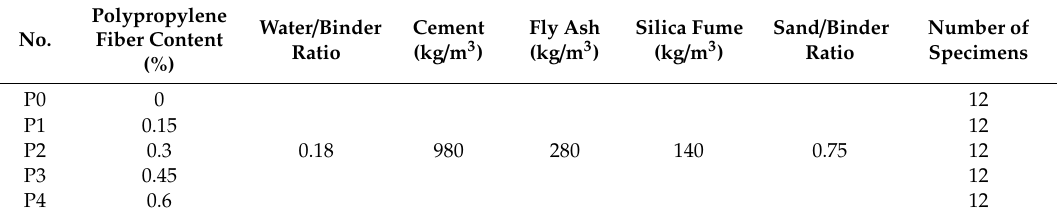
( e ) Figure 8. Splitting tensile strength failure mode of polypropylene fiber RPC: ( a ) 0%, ( b ) 0.15%, ( c ) 0.3%, ( d ) 0.45%, and ( e ) 0.6%. 3.1.3. Test Results of Mechanical Properties of Polypropylene Fiber RPC The test results of compressive strength and splitting tensile strength of different contents of polypropylene fibers for 7 and 28 days for are shown in Table 8. Table 8. Results of mechanical property test on polypropylene fiber RPC. No.